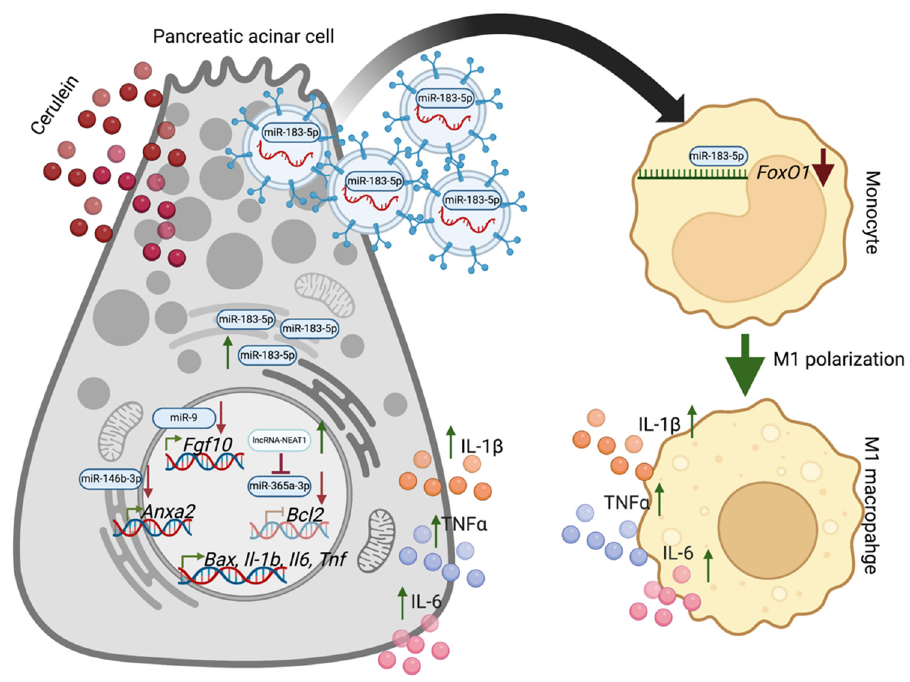
Figure 1. MiR-9, 146-3p, 365-3p, and 183-5p in the regulation of inflammatory response during acute pancreatitis role (please see text for details). Created with BioRender.com.